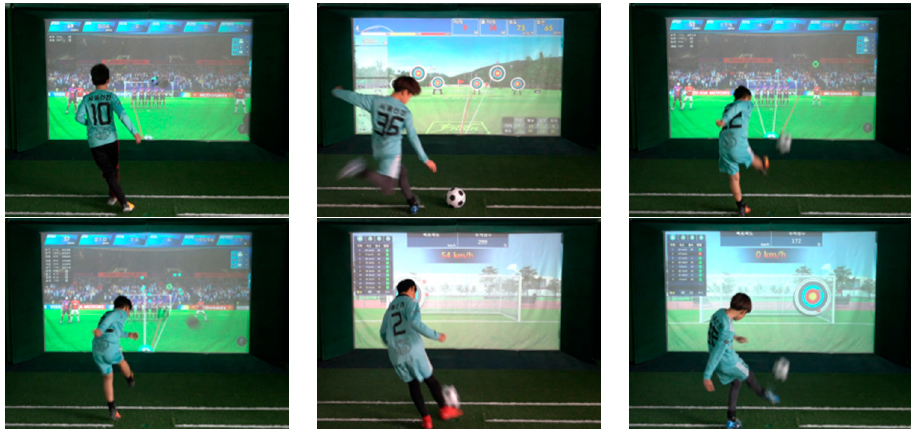
Figure 13. Screen-based simulation for training soccer kicks. Table 1. Physical characteristics of the training groups